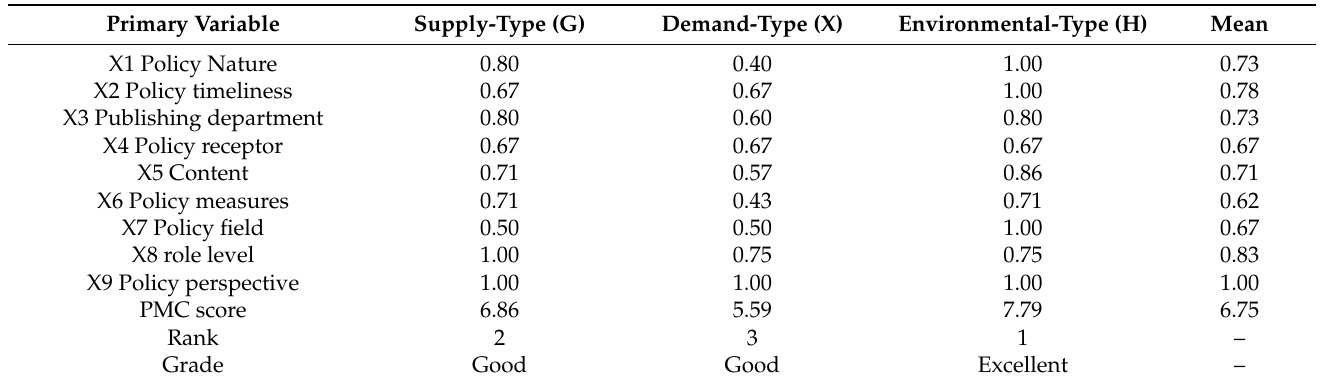
Table 8. PMC index and grade division table of policy